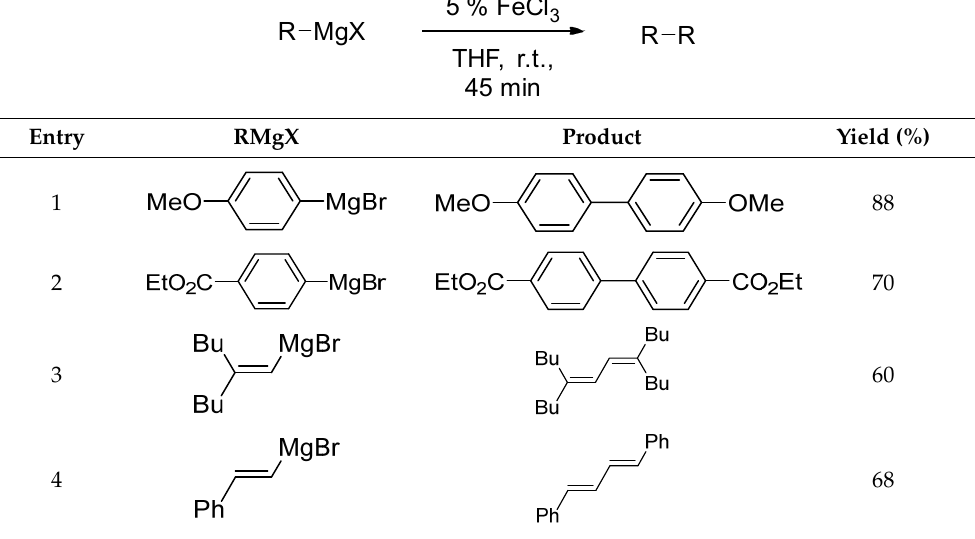
R MgX R MgX R MgX R MgX